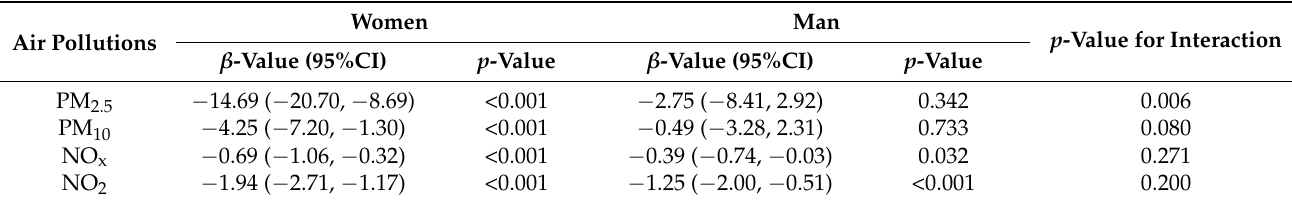
Table 3. Associations between air pollution (per 10 µ g/m 3 increase) and vitamin D in subgroups stratified by gender. Air Pollutions